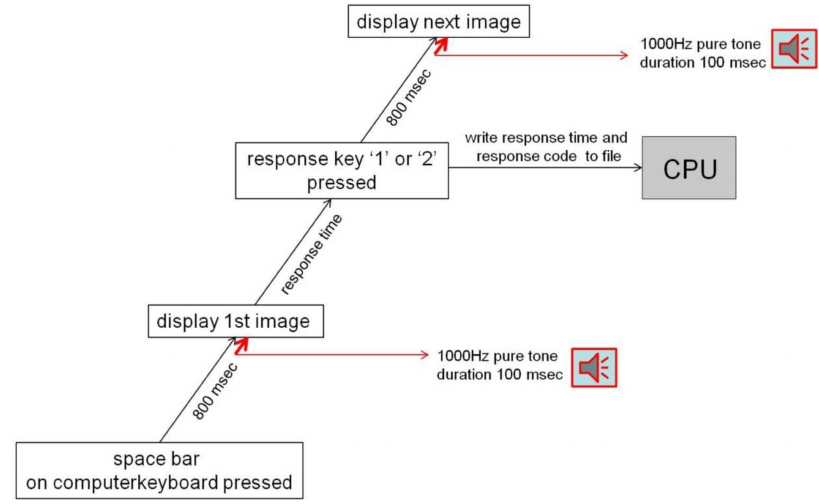
Figure 3. Flowchart of a trial sequence for a given individual